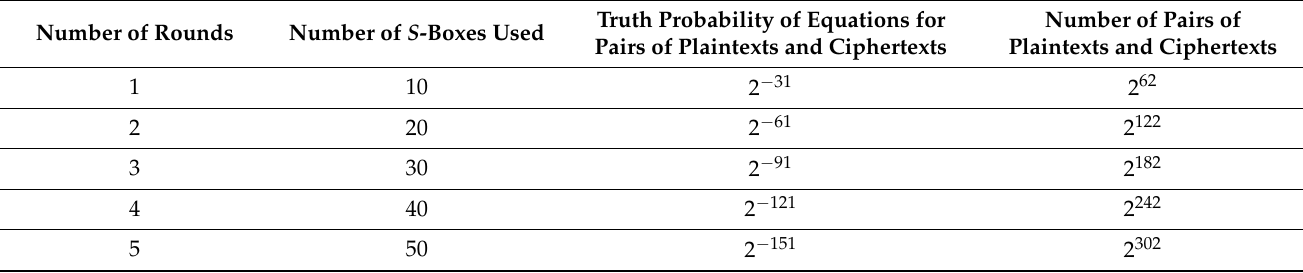
Table 11. Linear analysis of the AL02